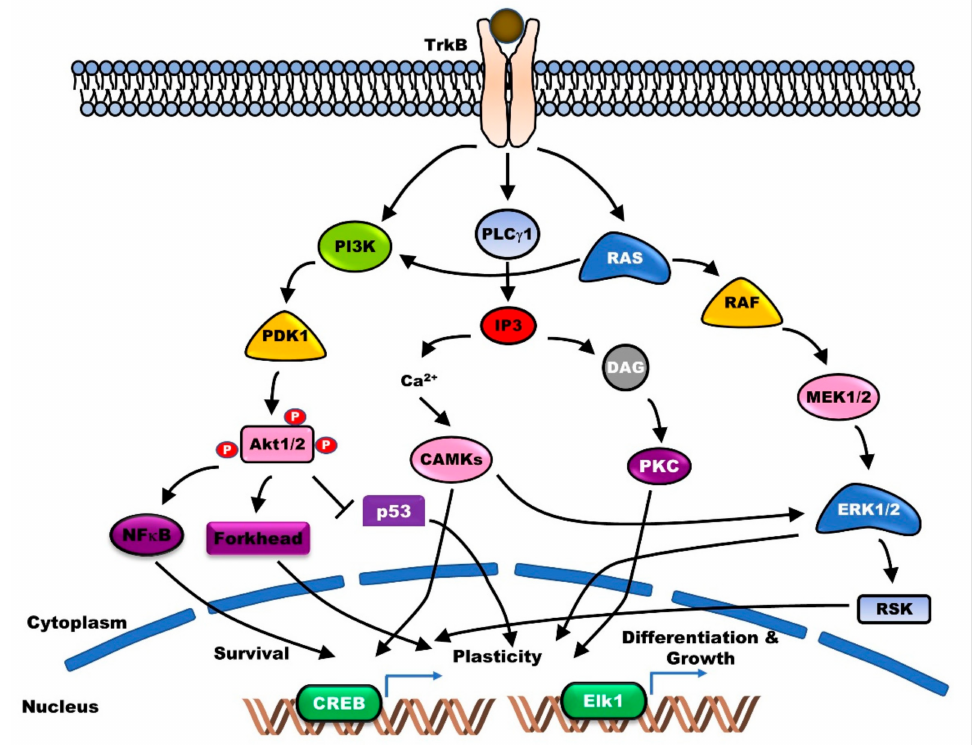
Figure 1. Brain-derived neurotrophic factor (BDNF) / tropomyosin-related kinase receptor type B (BDNF / TrkB) signaling supports neuronal survival, plasticity, di ff erentiation, and growth via activation of several functional downstream cascades. Binding BDNF to TrkB as its specific receptor leads to homodimerization and triggers activation of adaptor proteins such as polypyrimidine tract-binding protein (PTB) and Src homology domain 2 (SH2). Subsequently, activated adaptor proteins lead to activation of phosphoinositide 3-kinases (PI3K)-AKT (PI3K-AKT), Ras-mitogen-activated protein kinase (Ras-MAPK), and phospholipase C γ 1 (PLC- γ 1)-protein kinase C (PKC) signaling